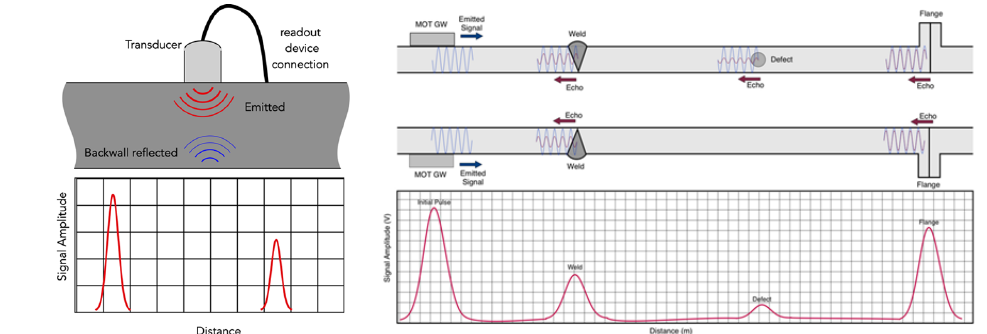
Figure 1. Representation of the conceptual difference between conventional ultrasonic testing (on the left ) and guided wave ultrasonic testing (on the right